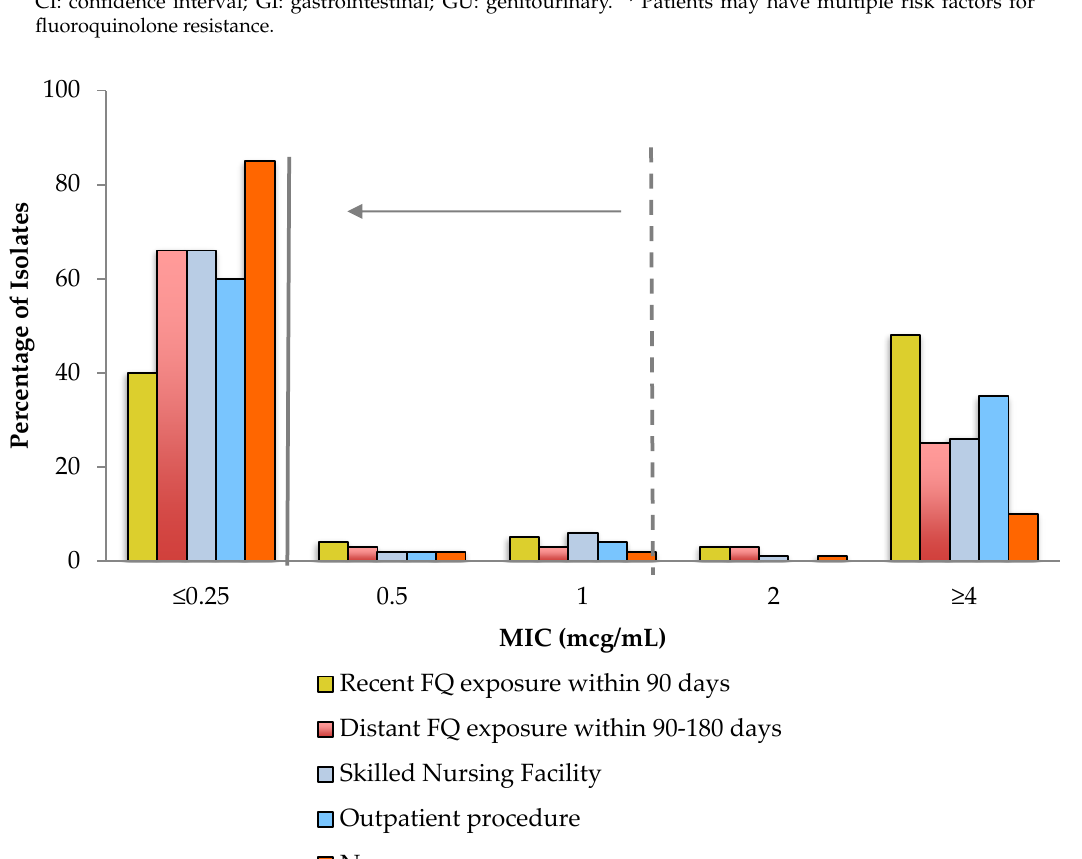
Figure 3. Ciprofloxacin MIC values for Enterobacteriaceae by risk factors for resistance. The dashed line represents the previous breakpoint and the solid line represents the updated breakpoint. FQ: